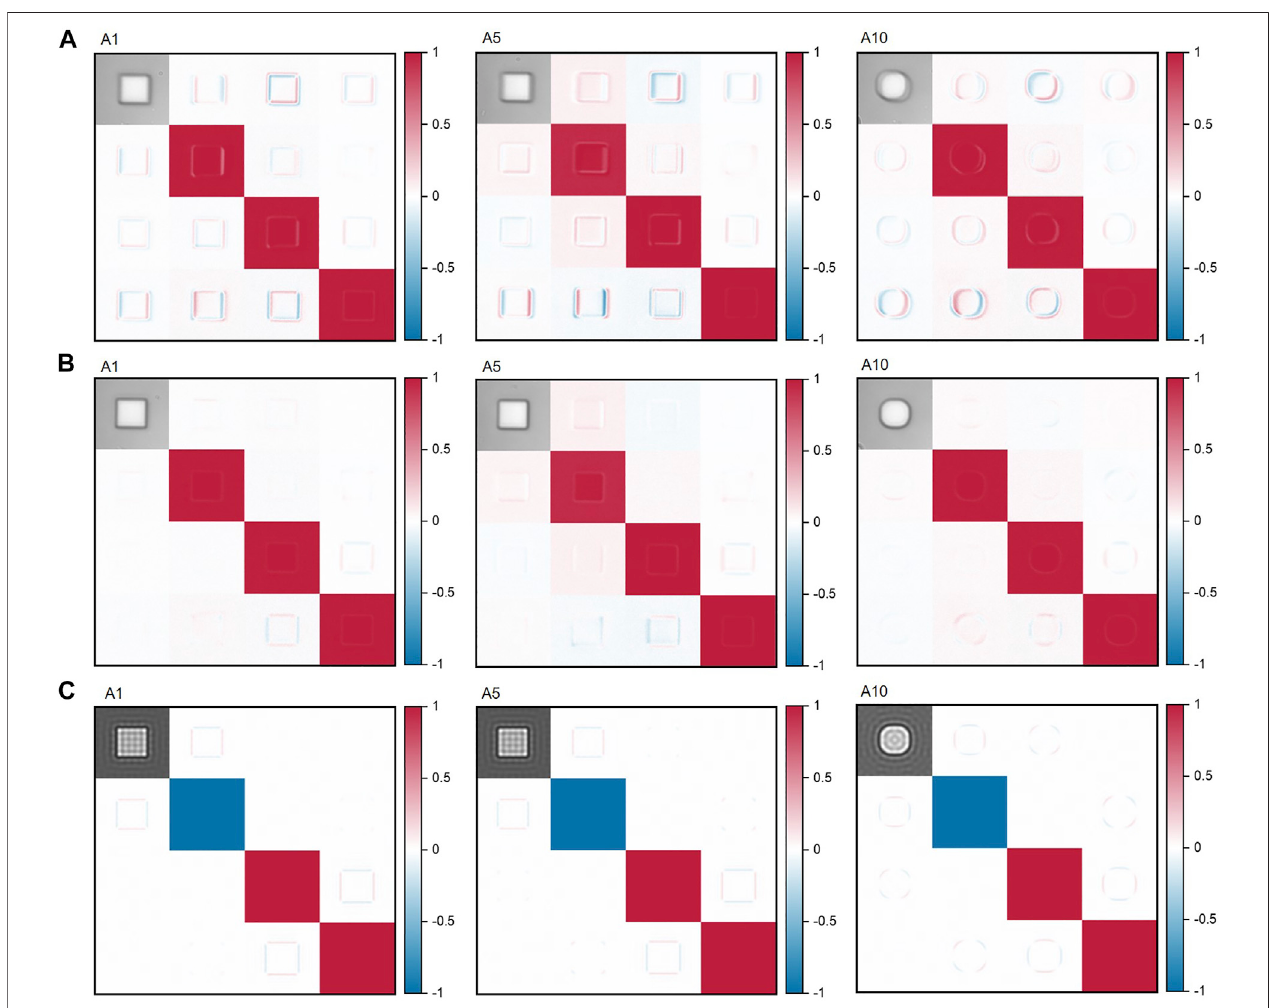
FIGURE5| MuellermatriximagesofstructuresA1,A5,andA10, (A) notcorrectedforthermaldrift, (B) correctedforthermaldrift,and (C) simulated.Targetfeature sizes: 5 μ m width and height, corner radii: 100 nm (A1), 400 nm (A5), 2000 nm (A10).